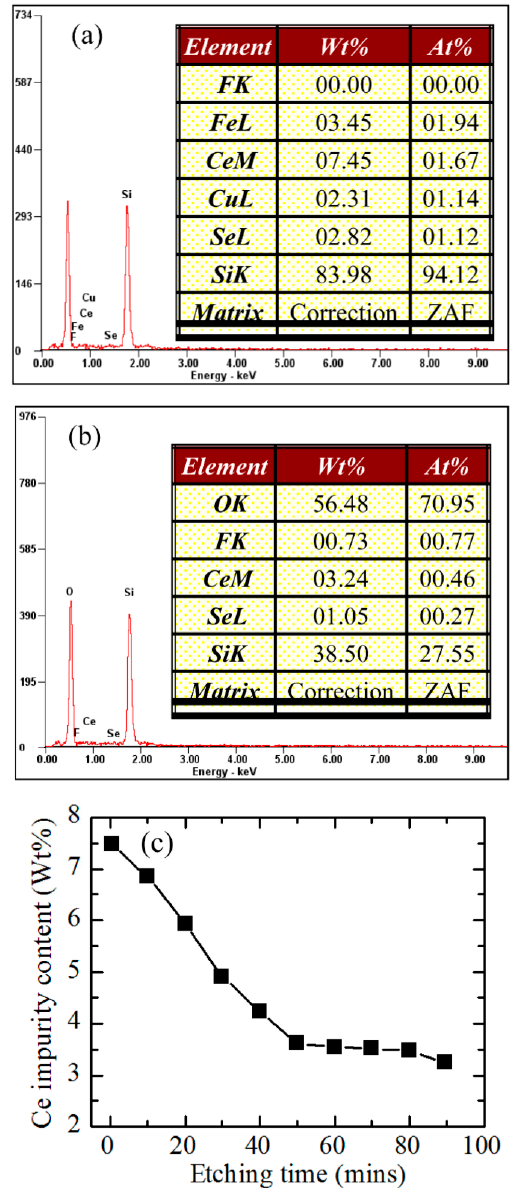
Figure 13. Tested results of impurity defects on polished silica surfaces before and after acid etching: ( a ) impurity contents before HF acid etching; ( b ) impurity contents after HF acid etching for 90 min; ( c ) Variation of Ce defect content for various etching times.